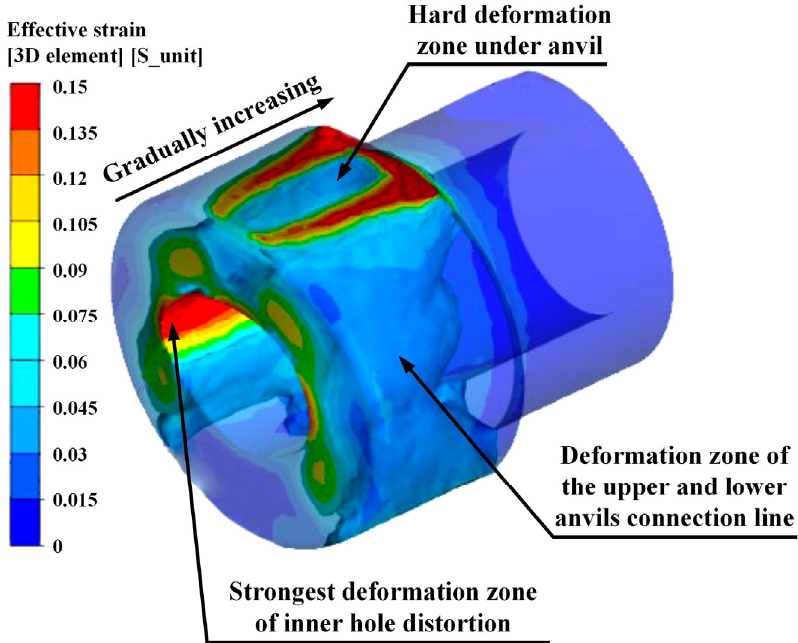
Figure 6. Effective strain distribution of the three-dimensional integral.